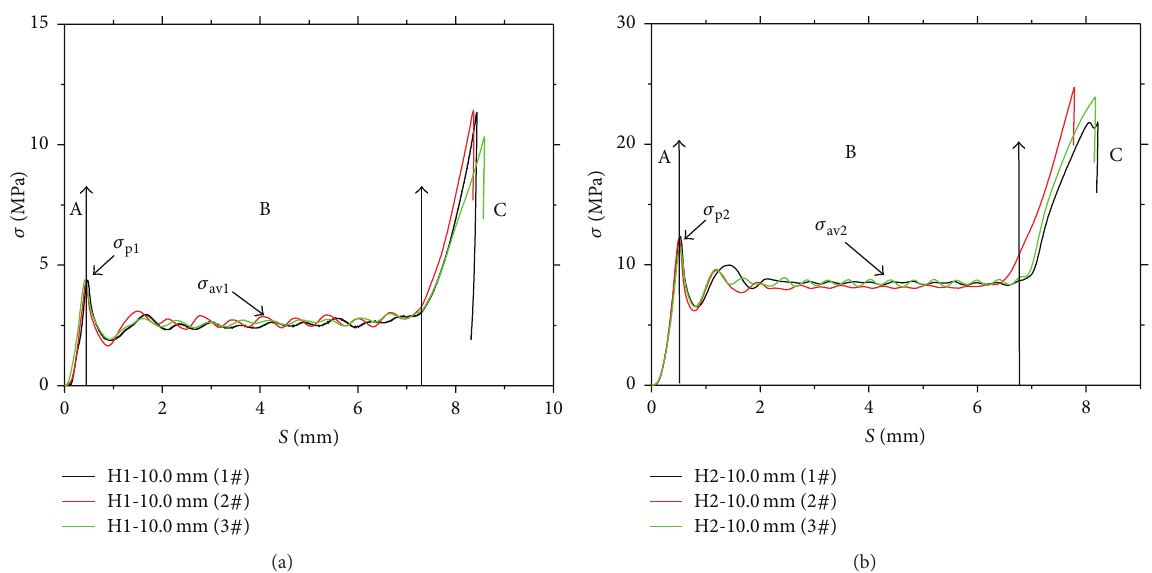
Figure 3: Compressive mechanical responses of SHAH. (a) H1 and (b) H2.